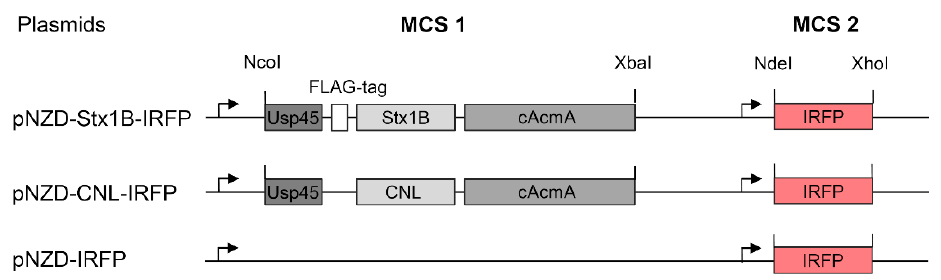
Figure 4. A scheme of the genetic constructs for the display of the Shiga holotoxin subunit B (Stx1B) lectin and Clitocybe (Stx1B) lectin and Clitocybe nebularis lectin (CNL) on the surface of Lactococcus lactis . nebularis lectin (CNL) on the surface of Lactococcus lactis